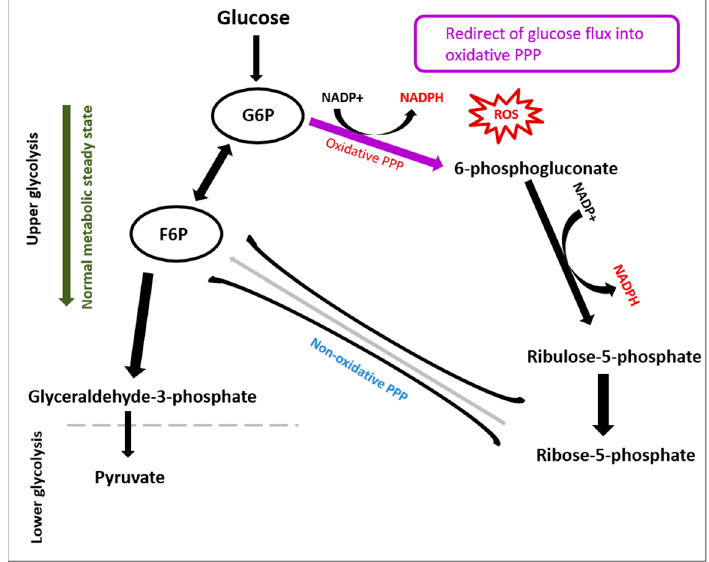
Figure 1. The rerouting of glucose flux into the pentose phosphate pathway (PPP) due to oxidative stress. Glycolysis was encouraged, while the activation of PPP by reactive oxygen species enhances the production of NADPH from NADP+.